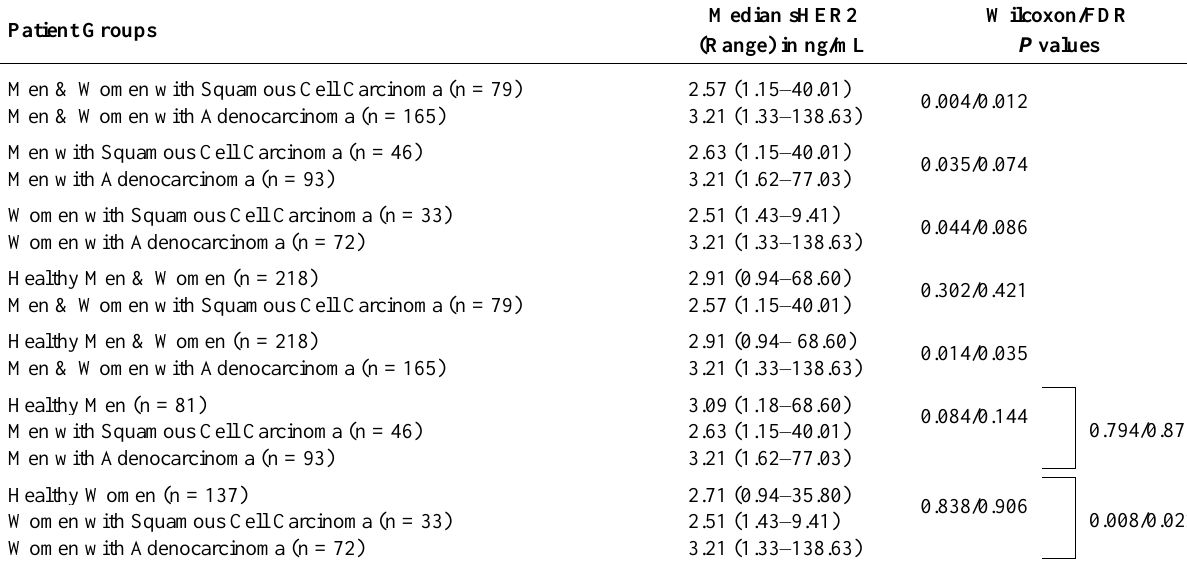
Table 2. Serum sHER2 concentrations by tumor histology. Serum sHER2 concentrations are compared between lung cancer cases with squamous cell carcinomas vs. adenocarcinomas by gender, and healthy men and women ( i.e ., controls) vs. patients with squamous cell carcinomas and adenocarcinomas by gender.